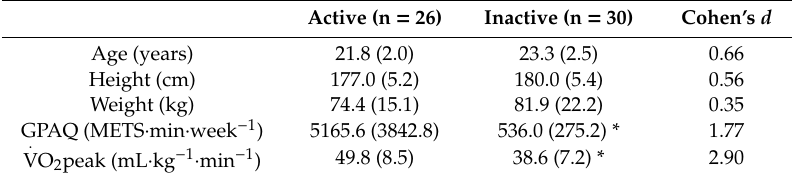
Table 1. Characteristics of study participants. Data are presented as mean (SD).